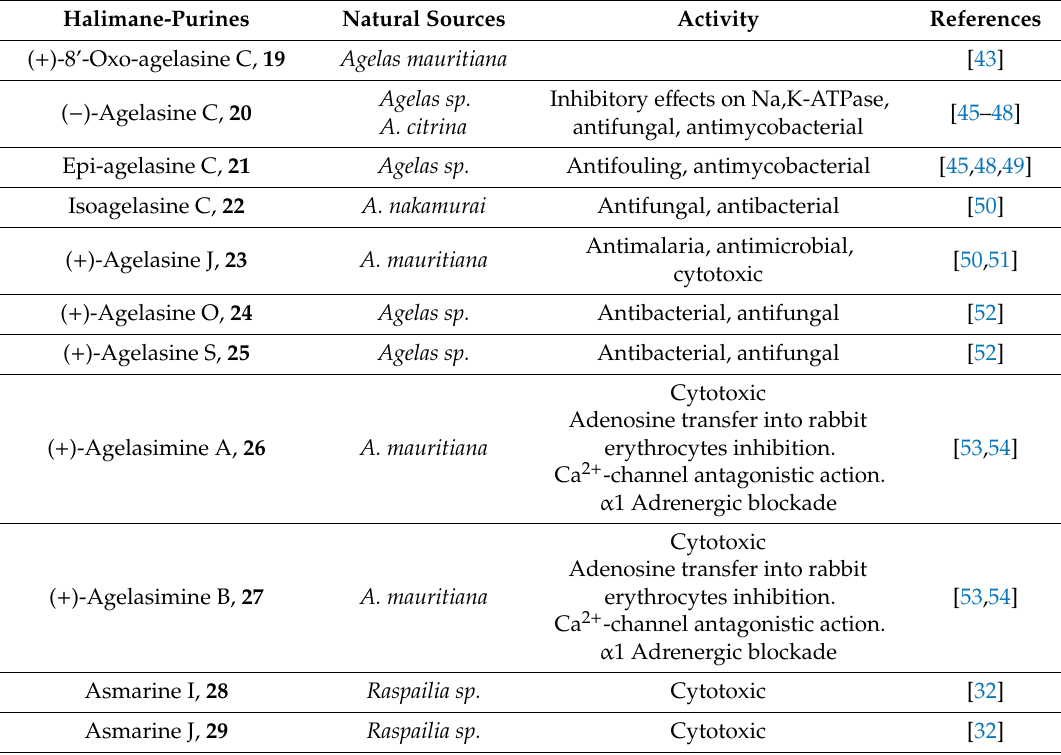
Table 3. Natural sources and activities of halimane-purines.